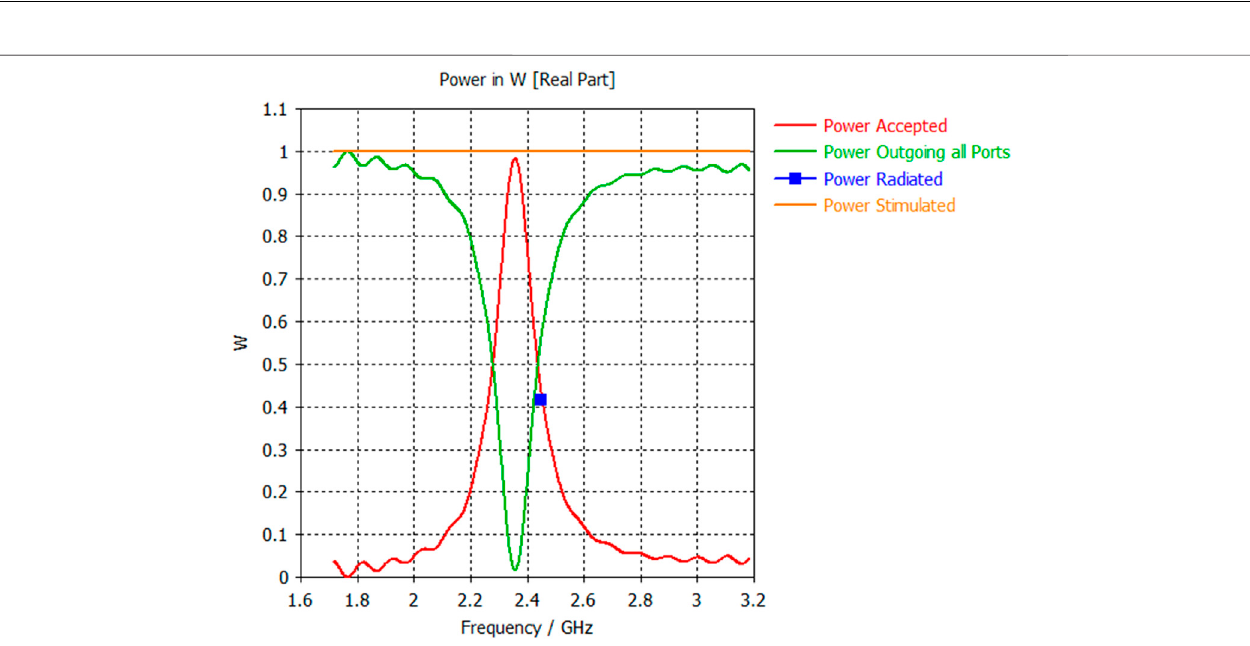
FIGURE 4 | Power radiated by